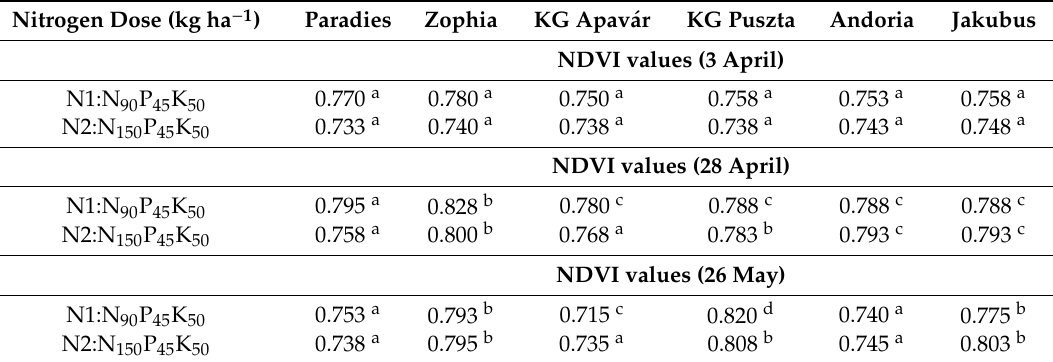
Table 5. NDVI values of winter barley cultivars (2020, Debrecen).